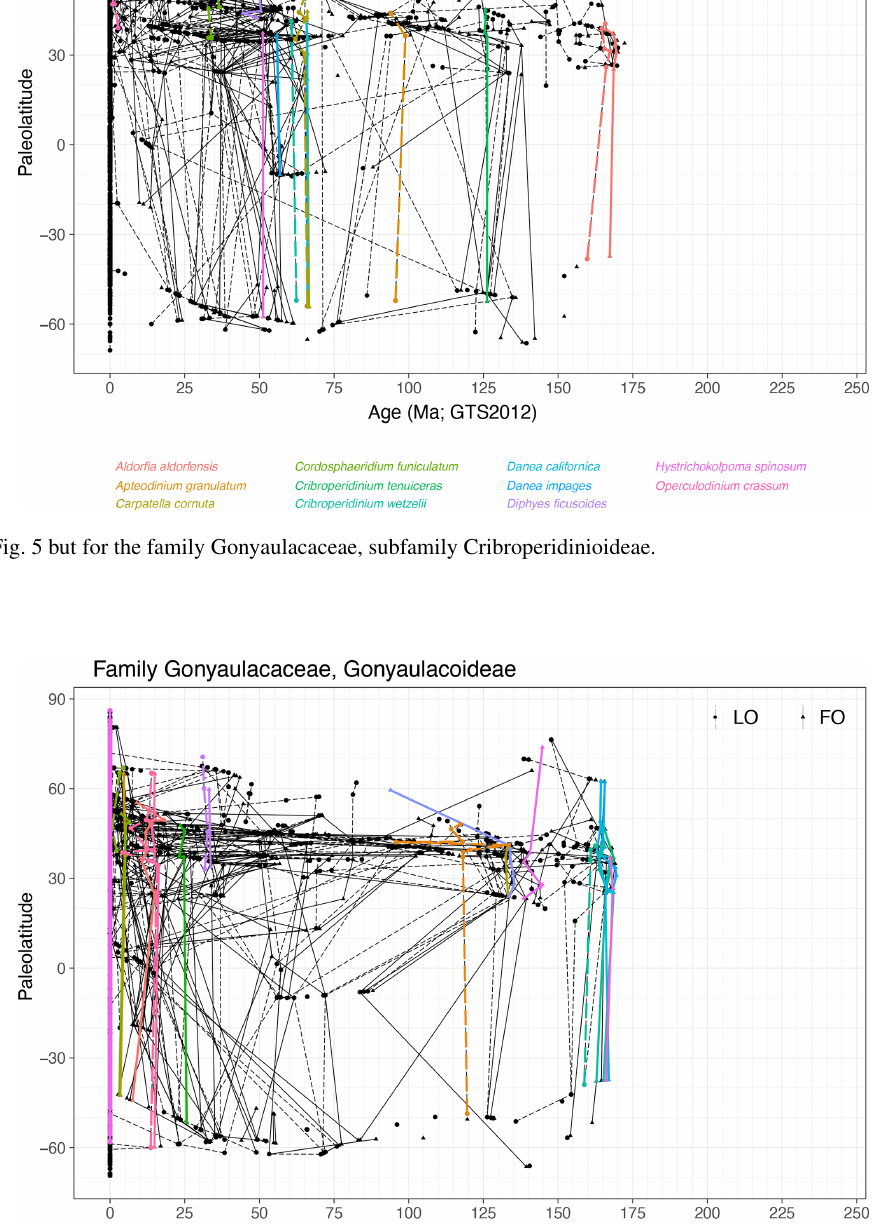
Earth Syst. Sci. Data, 14, 579–617, 2022